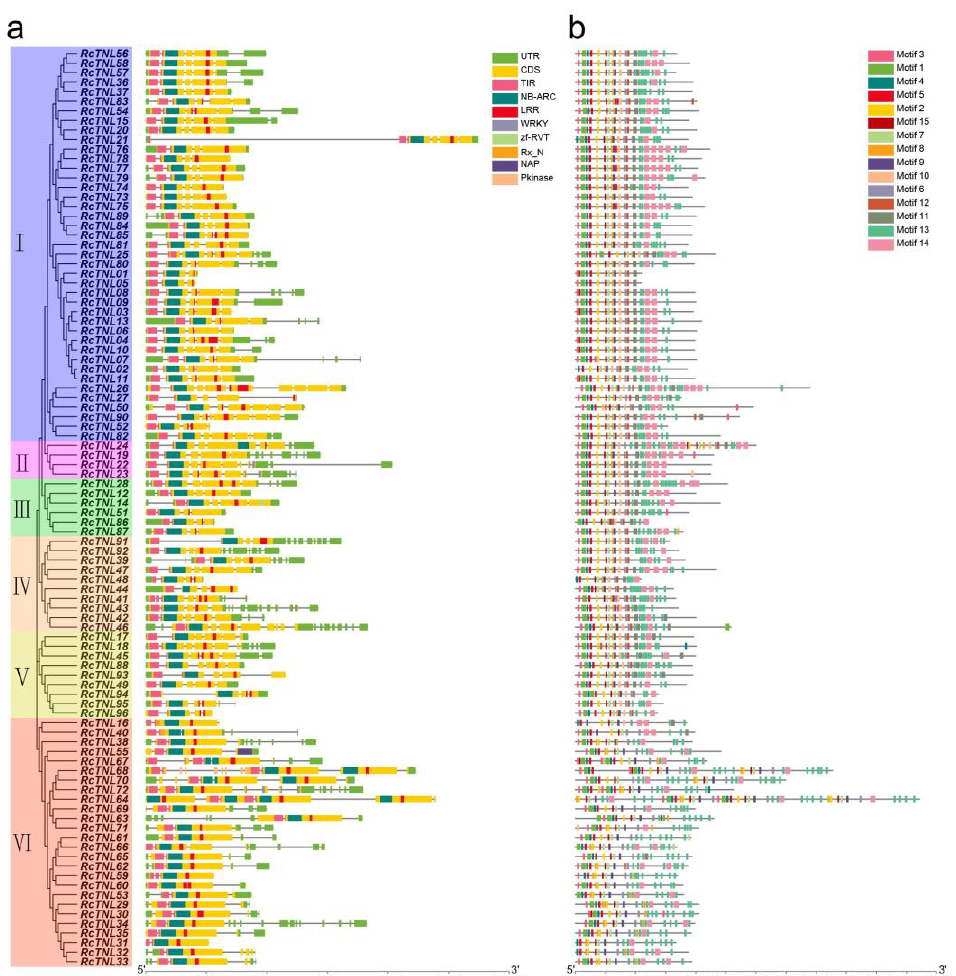
Figure 3. Phylogeny, conserved domains, and motifs of RcTNL proteins and their gene structures. ( a ) Gene structures and conserved domains of the RcTNL genes. The phylogenetic tree of the RcTNL genes is on the left with the six clades indicated by different background colors. Roman numerals indicate the clade numbers; rectangles of assorted colors to the right represent untranslated regions (UTRs), coding sequences (CDSs), and domains. The horizontal lines connecting rectangles represent introns. The rulers indicate base pair (bp) values. ( b ) Conserved motifs of the RcTNL proteins. The 15 motifs are represented by different colored rectangles. The horizontal lines of tandem rectangles indicate the extent of the protein.